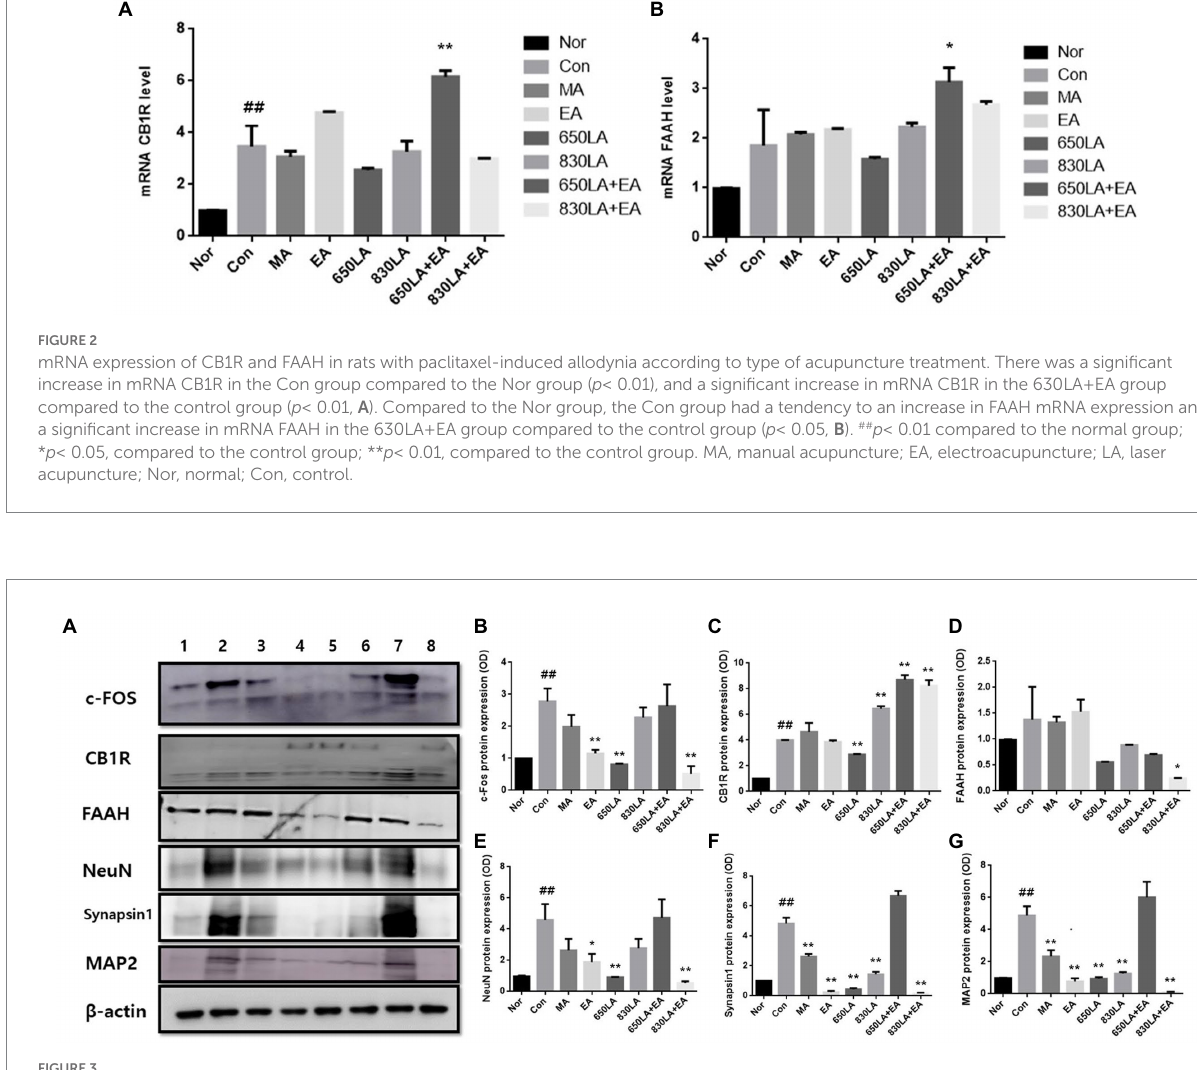
FIGURE 3 Protein expression in rats with paclitaxel-induced allodynia according to type of acupuncture treatment. The protein expression of c-Fos, CB1R, FAAH, NeuN, synapsin I, and MAP2 is shown (A) . The EA, 650 LA, and 830 LA + EA groups had significantly decreased c-Fos protein levels compared to the Con group ( p < 0.01, B ). There was a significant decrease in CB1R protein expression in the 650LA group and a significant increase in CB1R protein expression in the 830LA, 650LA + EA, and 830LA + EA groups compared to the Con group ( p < 0.01, C ). FAAH protein levels were significantly lower in the 830LA + EA group than in the Con group ( p < 0.05, D ). The EA, 650LA, and 830LA + EA groups had significantly lower NeuN protein levels than the Con group ( p < 0.05, p < 0.01, and p < 0.01, respectively, E ). The MA, EA, 650LA, 830LA, and 830LA + EA groups had significantly lower synapsin I protein levels than the Con group ( p < 0.01, F ). The MA, EA, 650LA, 830LA, and 830LA + EA groups had significantly lower MAP2 protein levels than the Con group ( p < 0.01, G ). Only the 650 LA + EA group showed a tendency to increase NeuN, synapsin I, and MAP2 compared to the control group, although the